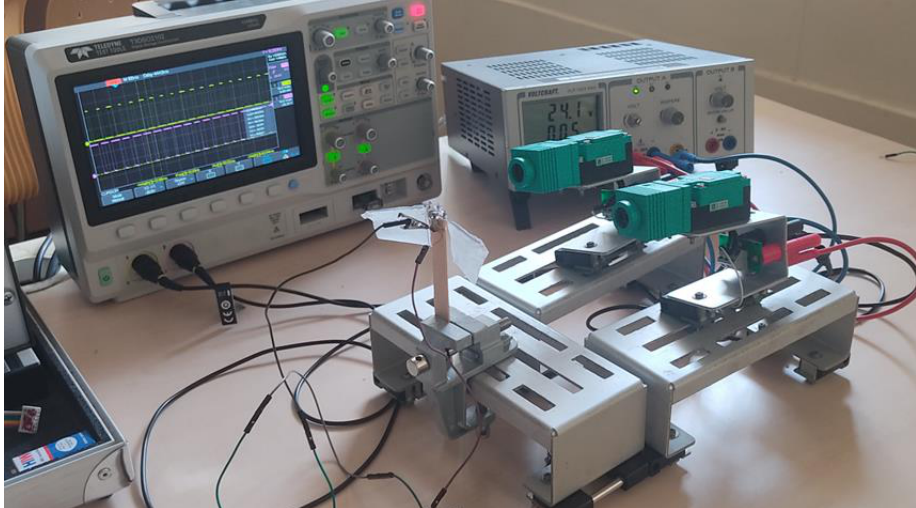
Figure 26. Phase lag between left- and right-wing measuring setup.